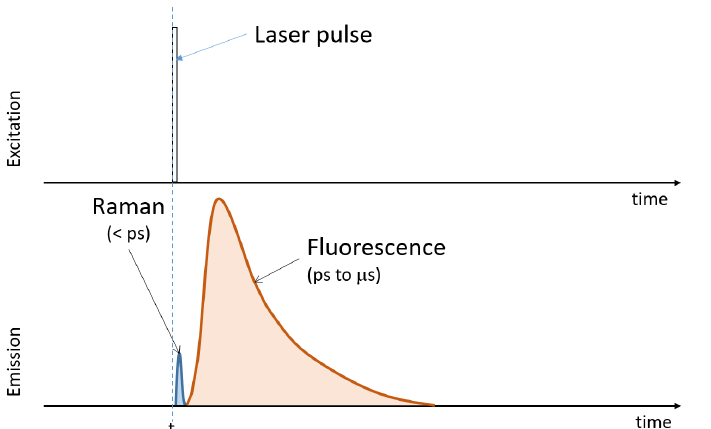
Figure 2. Temporal profile of the excitation laser pulse, emitted Raman scattering signal and emit- ted fluorescence.